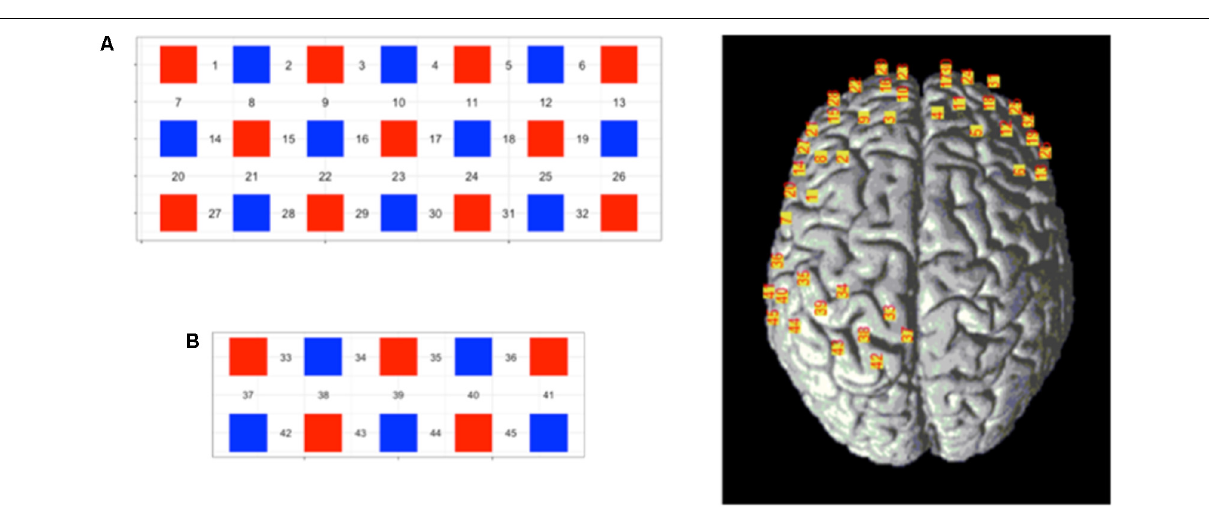
FIGURE 3 | Schematic representation of the 45-channel fNIRS probe sets placed on the participants’ scalps, separated into the frontal lobe [ (A) block, channels: 1—32] and occipital lobe [ (B) block, channels: 33–45]. Red squares represent light emitters, blue squares represent detectors, and numbers represent the measurement channels. Cranial optode channels in relation to the underlying anatomical structures are shown for one representative